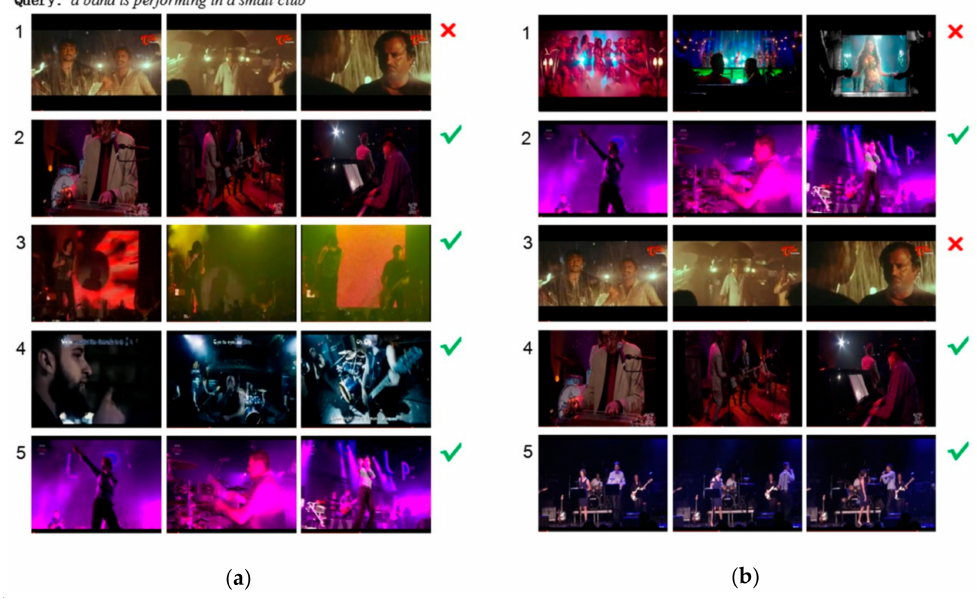
Figure 7. Top five video shots returned on MSR-VTT dataset with a query. ( a ) is our method and ( b ) is √ dual encoding. The video clip with in green means correct result, with × in red means